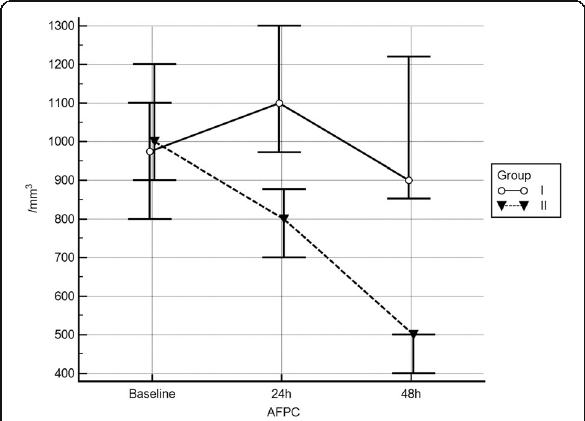
Fig. 1 Serial AFPC in both groups